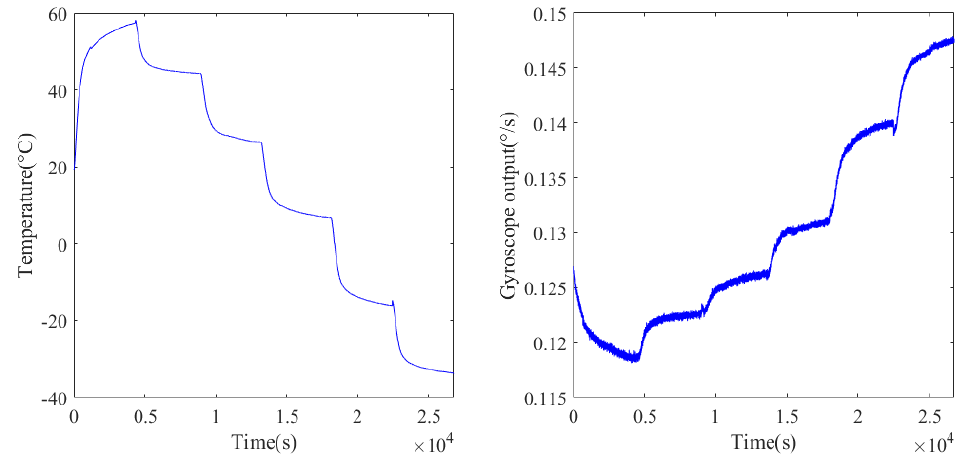
Figure 10. Experimental temperature change and the corresponding gyroscope output.